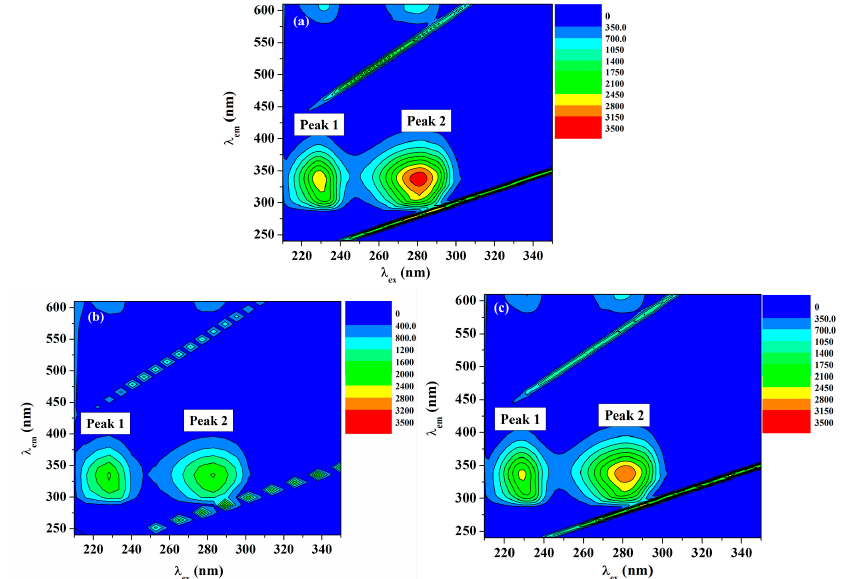
Figure 9. Contour plot of the fluorescence intensity spectra of ( a ) HSA, ( b ) ACV-HSA and ( c ) PNV-HSA systems.